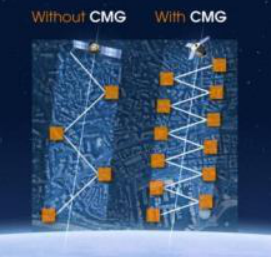
Figure 2 – Illustration of CMG’s effect on collection capability